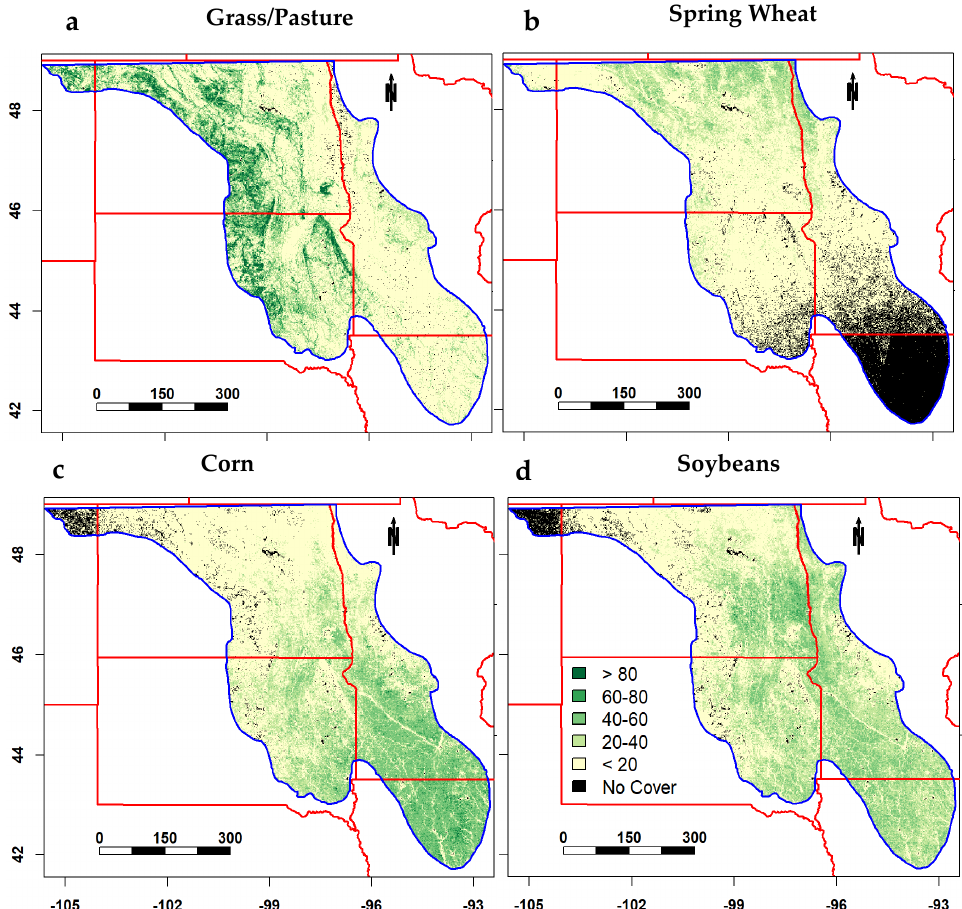
Figure 3. Mean land cover percentages for the US Prairie Pothole Region from 2006 through 2018 calculated from the USDA NASS CDL at 510 m resolution. Black pixels within the blue polygon indicate nonexistence of a given cover type within the study area. US–PPR boundary appears in blue, and state borders in red. Note the scalebar unit is km.